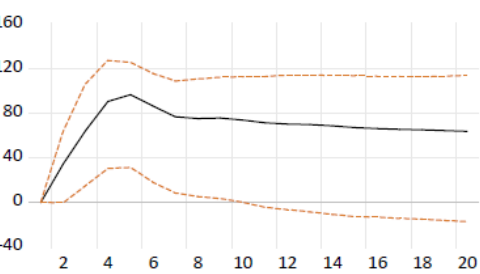
Table 10. Outcomes of the Forecast Error Variance Decomposition on MPO. Step